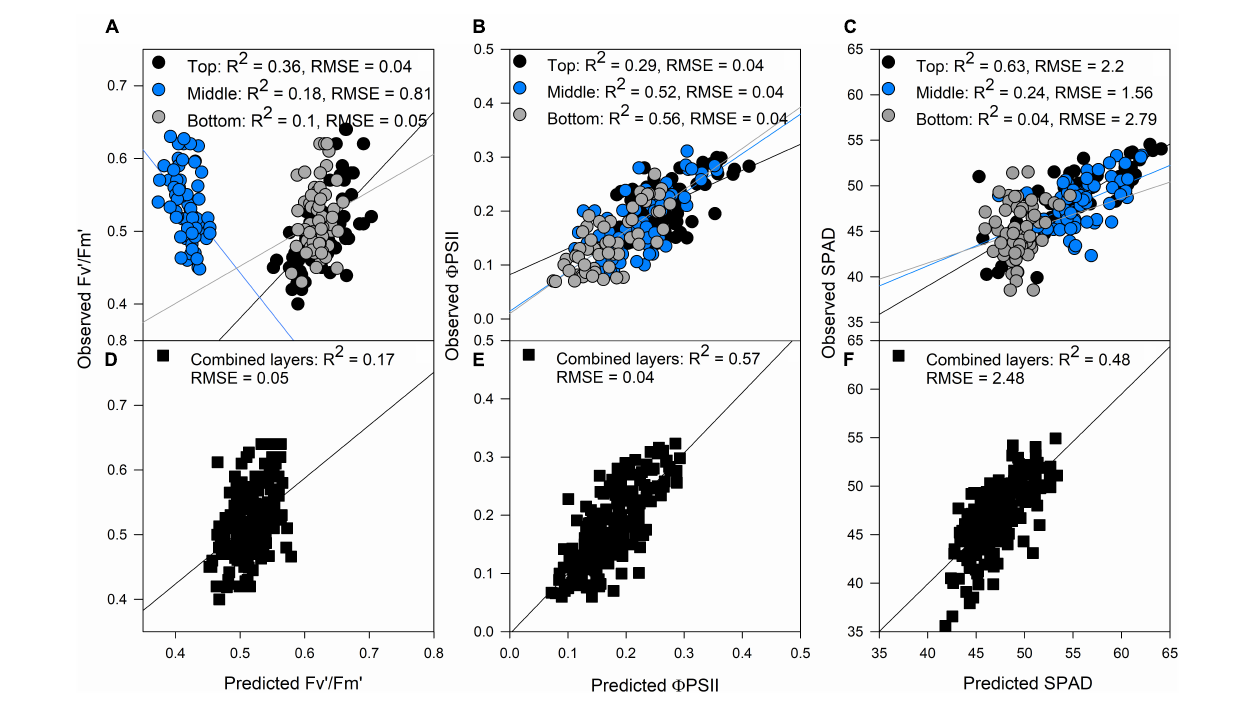
FIGURE 1 | Validation results of partial least squares regression (PLSR) models predicting Fv (cid:48) /Fm (cid:48) (A) , (cid:56) PSII (B) , and SPAD (C) by separating each layer of the canopy (top panels) and predictions of Fv (cid:48) /Fm (cid:48) (D) , (cid:56) PSII (E) , and SPAD (F) combining all the layers of the canopy (black squares). Black dots: top of the canopy, blue dots: middle of the canopy, gray dots: bottom of the canopy. The lines represent the linear regression between predictions and ground truth